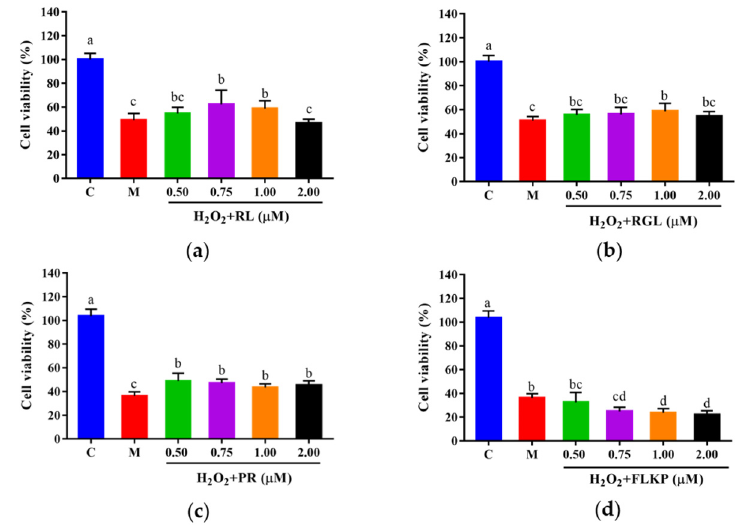
Figure 11. Cell viabilities of HepG2 cells with oxidative stress treated with synthetic peptides: ( a ) synthetic peptide RL; ( b ) synthetic peptide RGL; ( c ) synthetic peptide PR; ( d ) synthetic peptide FLKP. “C” represents the control group, and “M” represents the model group. Data were expressed as mean ± SD ( n ≥ 3, p < 0.05). Different letters indicate significant differences ( p < 0.05).